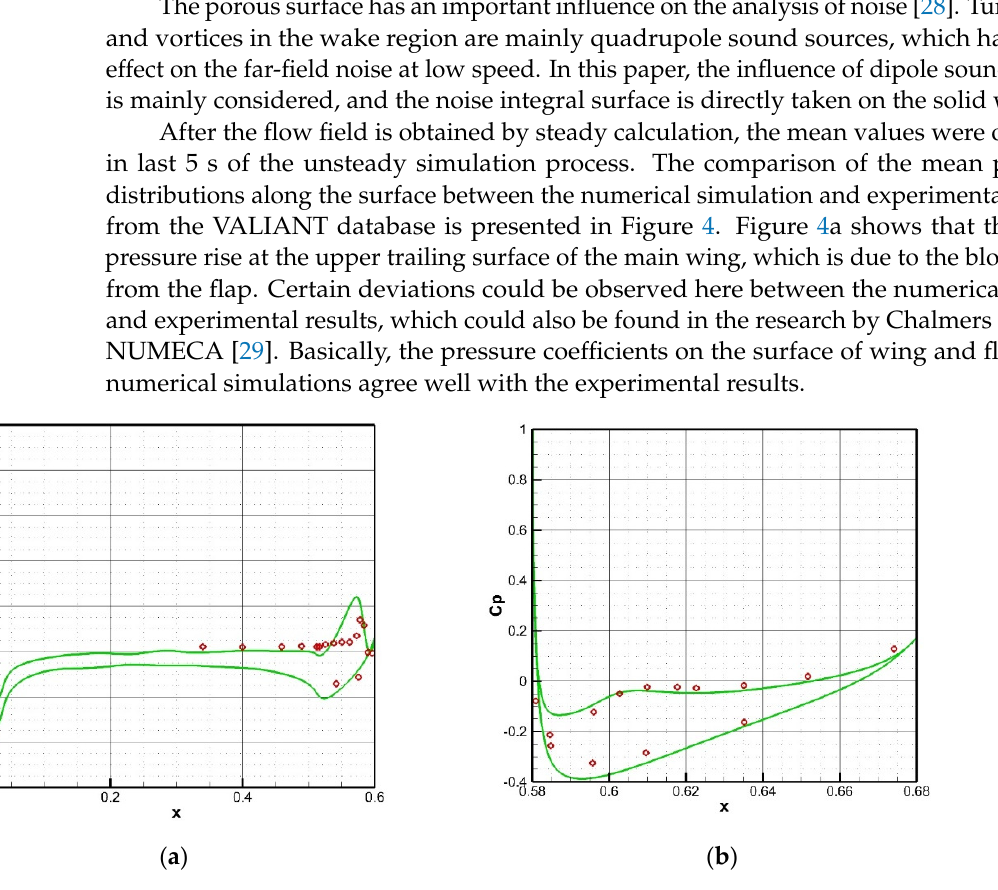
Figure 4. Comparing results between numerical simulation and experiment: on main wing ( a ); on flap ( b ). on flap ( b